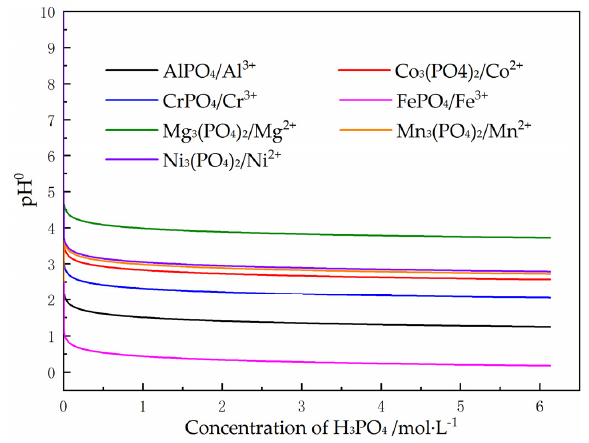
Metals 2020 , 10 , x FOR PEER REVIEW Figure 6. Initial precipitation pH of metals phosphate as the function of H 3 PO 4 concentration. Figure 6. Initial precipitation pH of metals phosphate as the function of H 3 PO 4 concentration. Figure 6. Initial precipitation pH of metals phosphate as the function of H 3 PO 4 concentration.